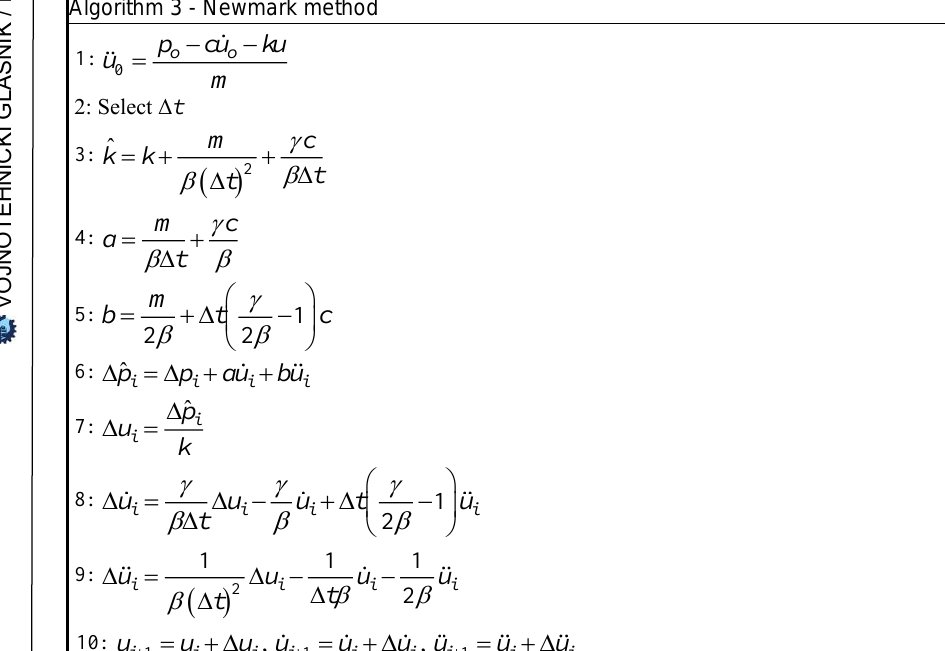
Algorithm 3 - Newmark